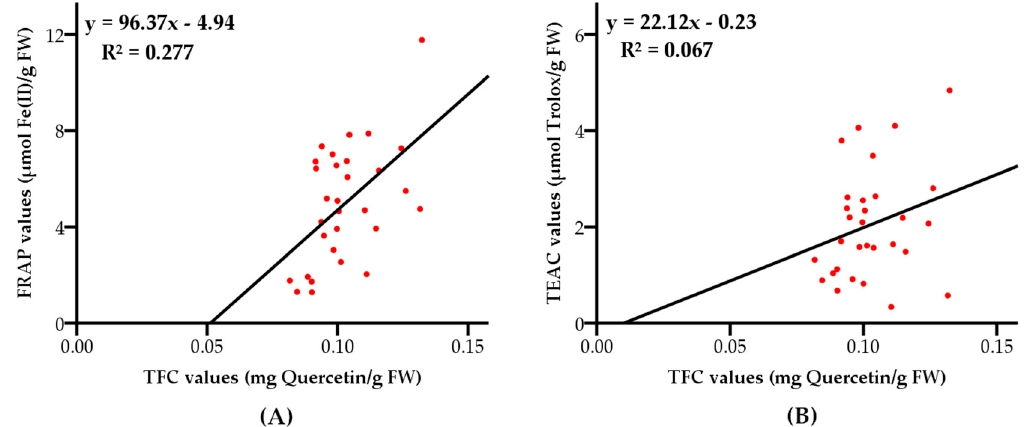
Figure 9. Correlations between FRAP values ( A ), TEAC values ( B ) and total flavonoid contents of the 30 grape varieties.